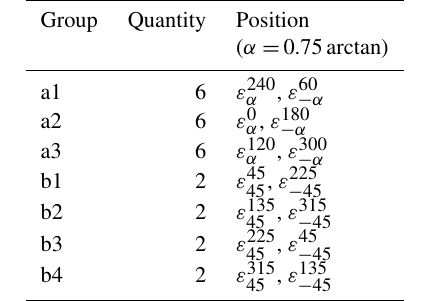
Table 1. The corresponding spatial orientation of each sensor group. Group Quantity Position ( α =